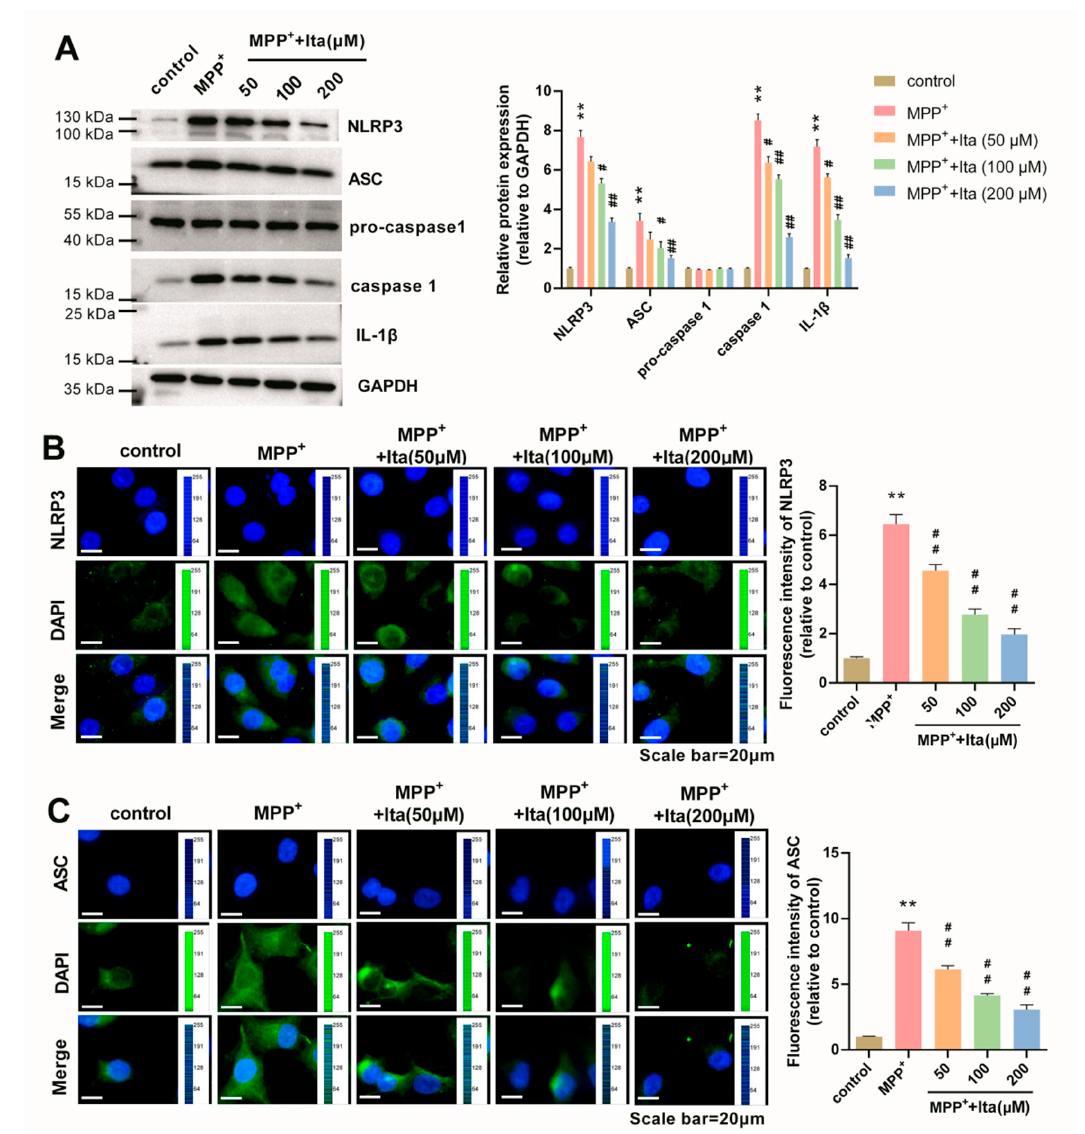
Figure 8. Itaconate inhibited the activation of NLRP3 inflammasome in MPP + revulsive PD cell model. ( A ) The expression of NLRP3, ASC, pro-caspase 1, caspase 1, and IL-1 β in MPP + revulsive PD cell model was measured using Western blotting. GAPDH serves as an internal control. ( B ) The expression of NLRP3 in MPP + -induced SH-SY5Y cells was analyzed by immunofluorescence (magnification, × 400). ( C ) The expression of ASC in MPP + -induced SH-SY5Y cells was analyzed by immunofluorescence. The image acquisition parameters: image resolution ( − 4908 × 3264), objective (10 × ), and exposure settings (DAPI: 5 ms, NLRP3: 300 ms, ASC: 100 ms). n = 3. ** p < 0.01 vs. control group; # p < 0.05, ## p < 0.01 vs. MPP + group. GAPDH, glyceraldehyde-3-phosphate dehydrogenase; IL-1 β , interleukin 1 β ; Ita, Itaconate.